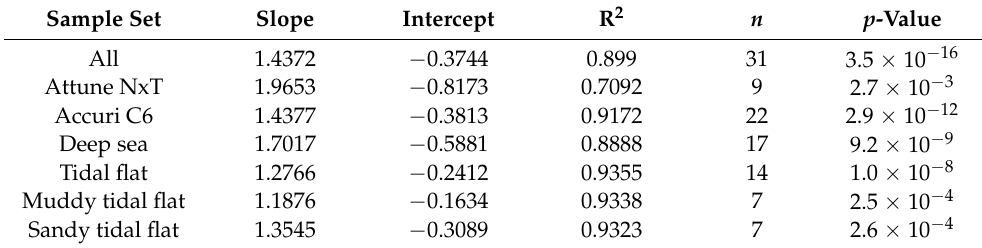
Figure 4. Regression of viral abundances enumerated from marine sediment samples ( n = 31) by epifluorescence microscopy (EfM) and flow cytometry (FCM). Samples include deep-sea sediments (dark blue) and tidal-flat sediments (light blue). Results from the Accuri C6 flow cytometer are indicated by circles, and from the Attune NxT by triangles. The regression line (solid line) is shown along with 99% confidence intervals (dashed lines). Results are displayed in logarithmic scale. Table 2. Linear regression analysis of viral abundances determined by flow cytometry and epiflu- orescence microscopy (from Figure 4). Regression analysis of individual results from both flow cytometers (Attune NxT and Accuri C6) and individual sediment types (deep sea, tidal flat, muddy, sandy) are